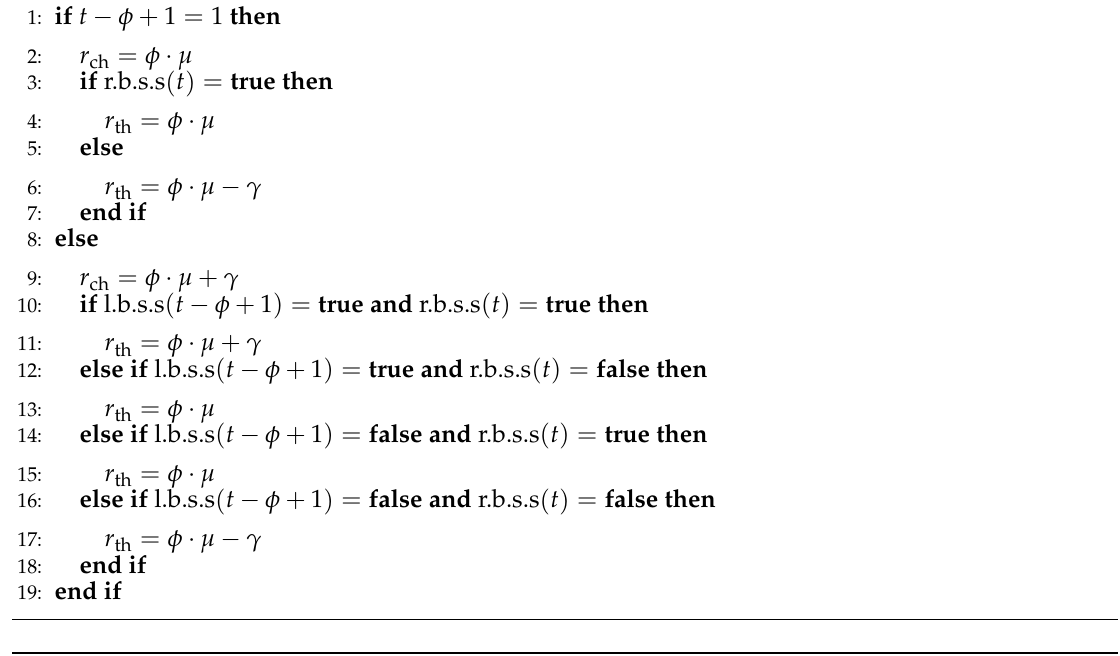
( t ) p for chunk t